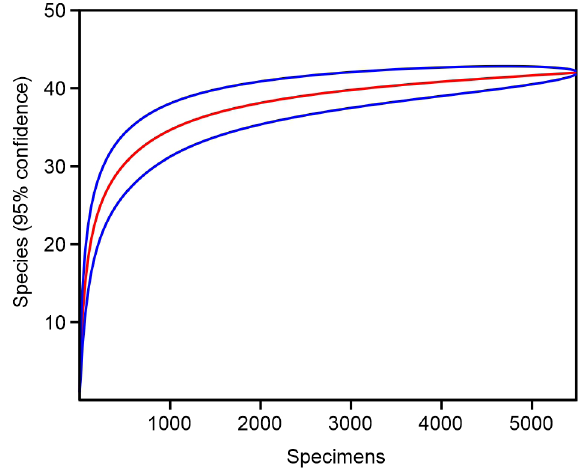
Figure 12. Rarefaction curve with 95% confidence intervals of the palynofloristic species from the Snow